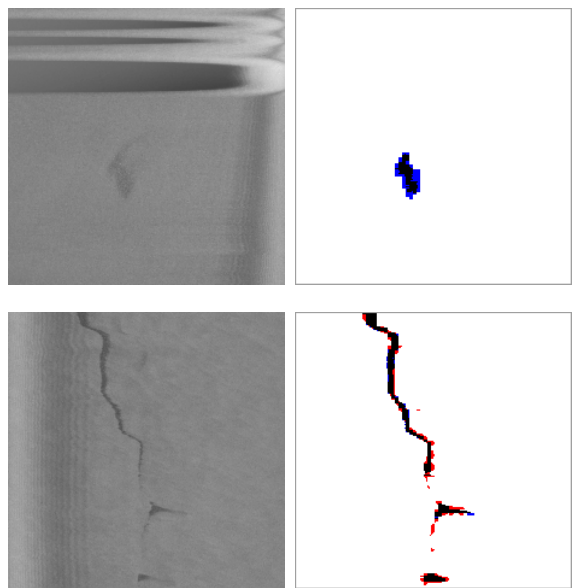
Figure 9. Results of processing two SLAR input images with the proposed method (zooming in the area of interest). The first column shows the original SLAR images and the second column shows the detection results. Black areas depict correct detections of oil spills, red and blue pixels depict FP and FN of oil spills, respectively, and white pixels represents correct detections of the